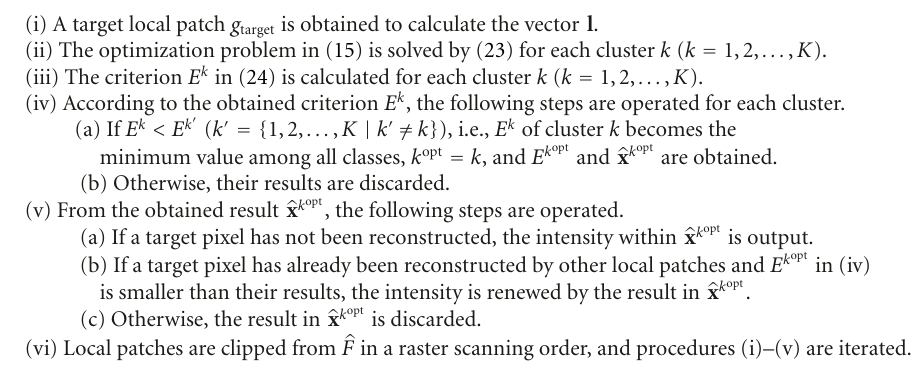
Algorithm 1: Specific procedures of the high-frequency component estimation in the proposed